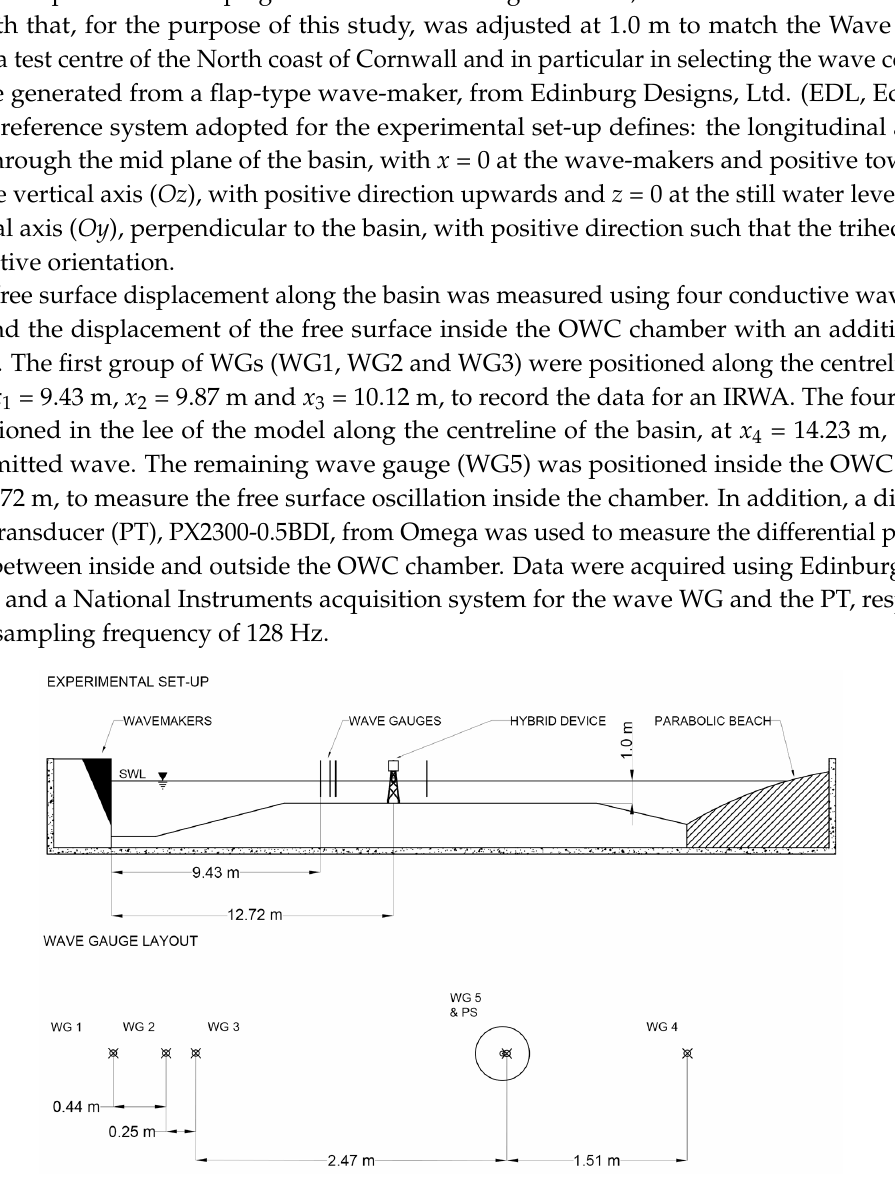
Figure 4. Side and top views of the experimental set-up.